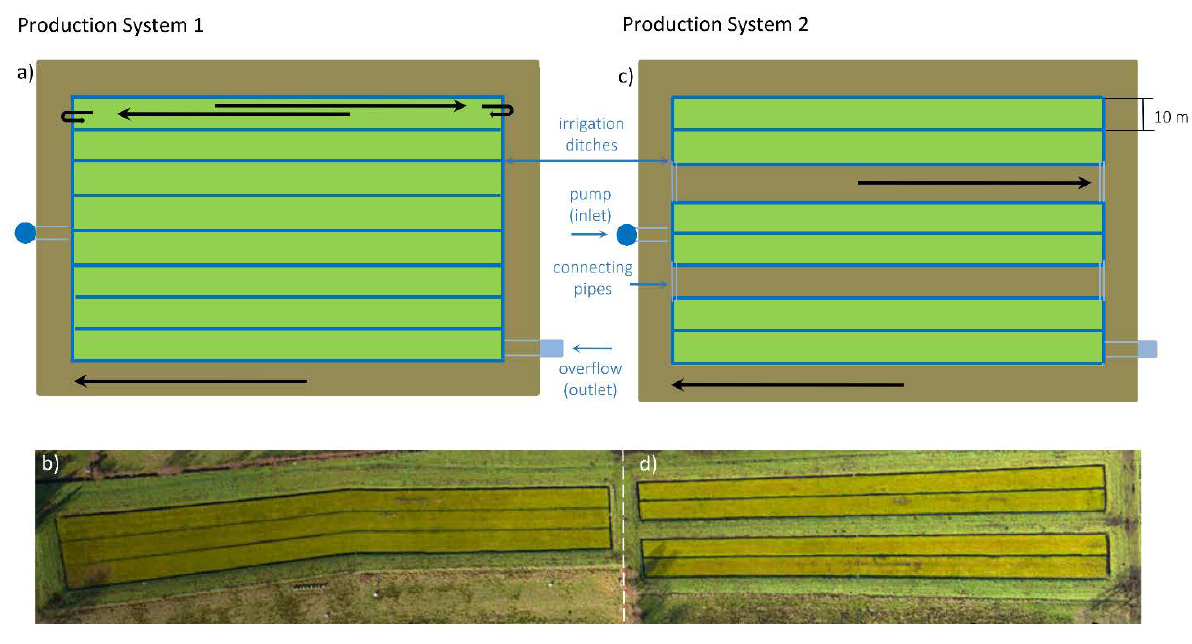
Figure 2. Soil-based Sphagnum culture (plan views). Production System 1 (PS 1) requires machines that can be driven (black arrows) onto the Sphagnum production strips (green), despite their low bearing capacity; the causeways (brown) provide a turning area for the machines and allow the transport of harvested biomass: a) schematic illustration, b) field experiment with three neighbouring production strips. Production System 2 (PS 2) provides more causeways for weed control machinery, moss harvesting and biomass transport: c) schematic illustration (following Wichmann et al. 2014), d) field experiment with 2 × 2 production